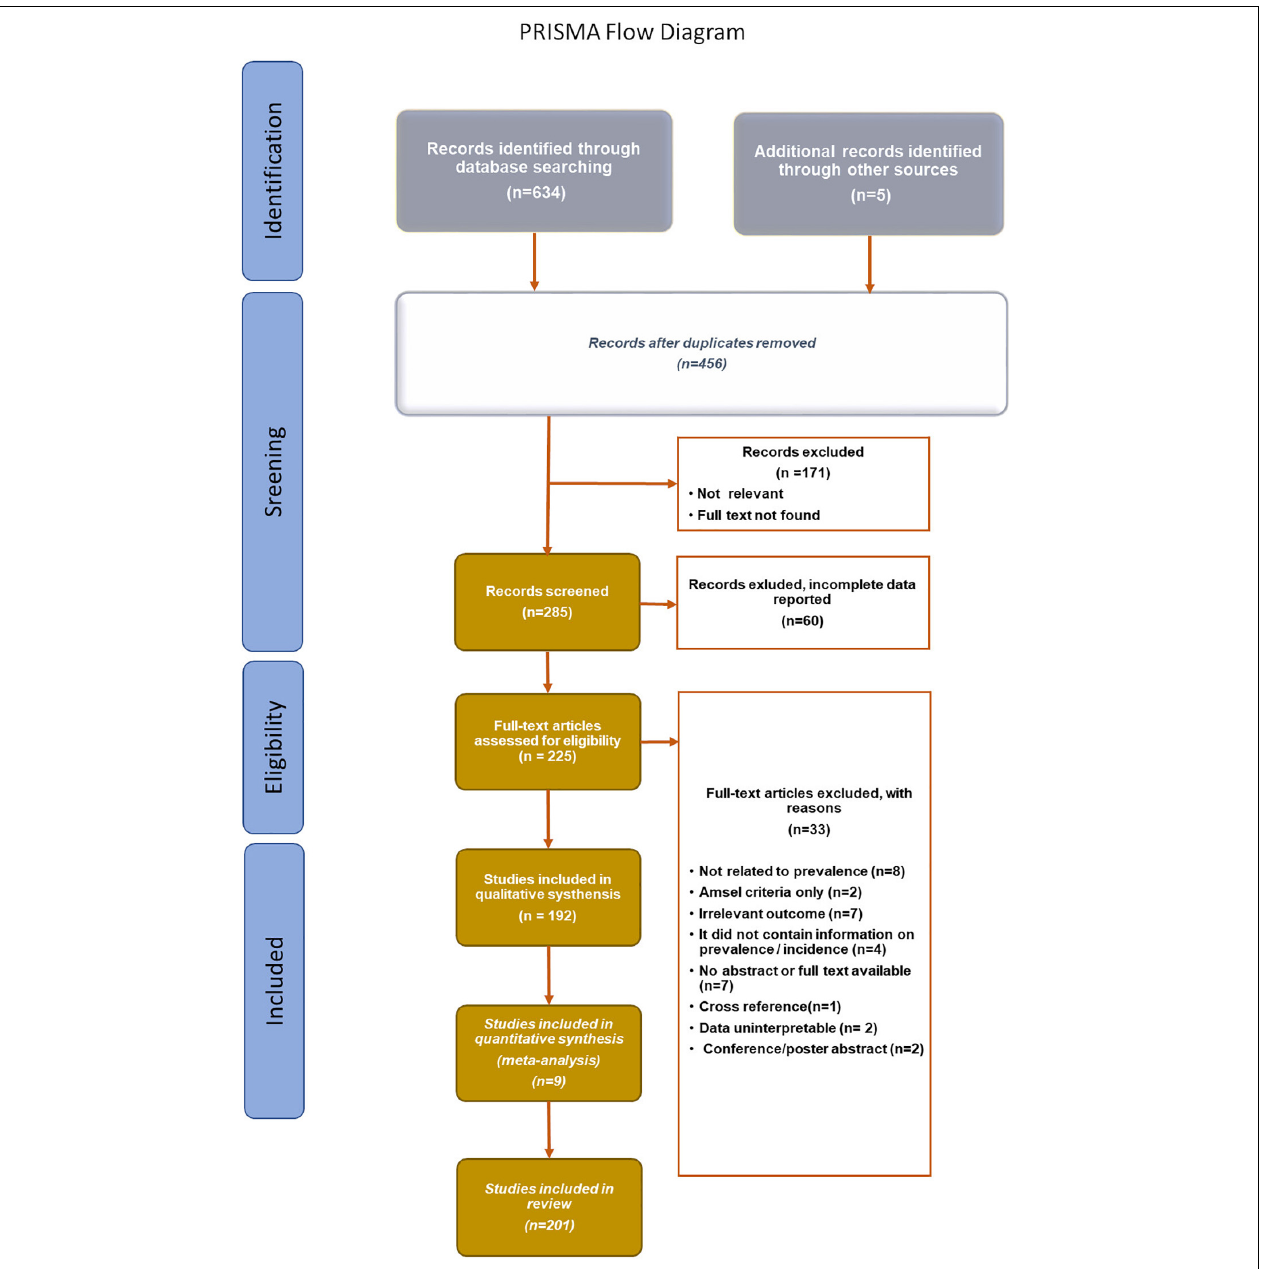
FIGURE 2 | PRISMA Flow diagram (Moher et al.,